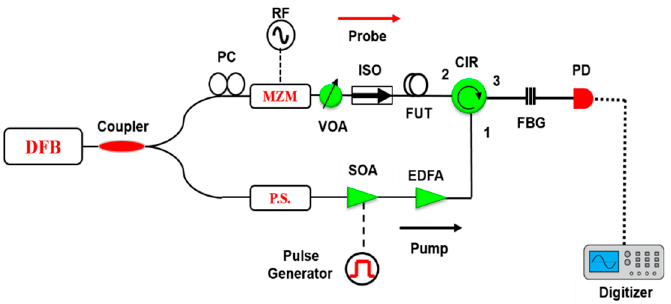
Figure 3. Experimental setup: RFG: radio frequency generator, PC: polarization controller, MZM: Mach–Zehnder modulator, VOA: variable optical attenuator, ISO: isolator, FUT: fiber under test, CIR: circulator, FBG: fiber Bragg grating, PS: polarization scrambler, SOA: semiconductor optical amplifier,